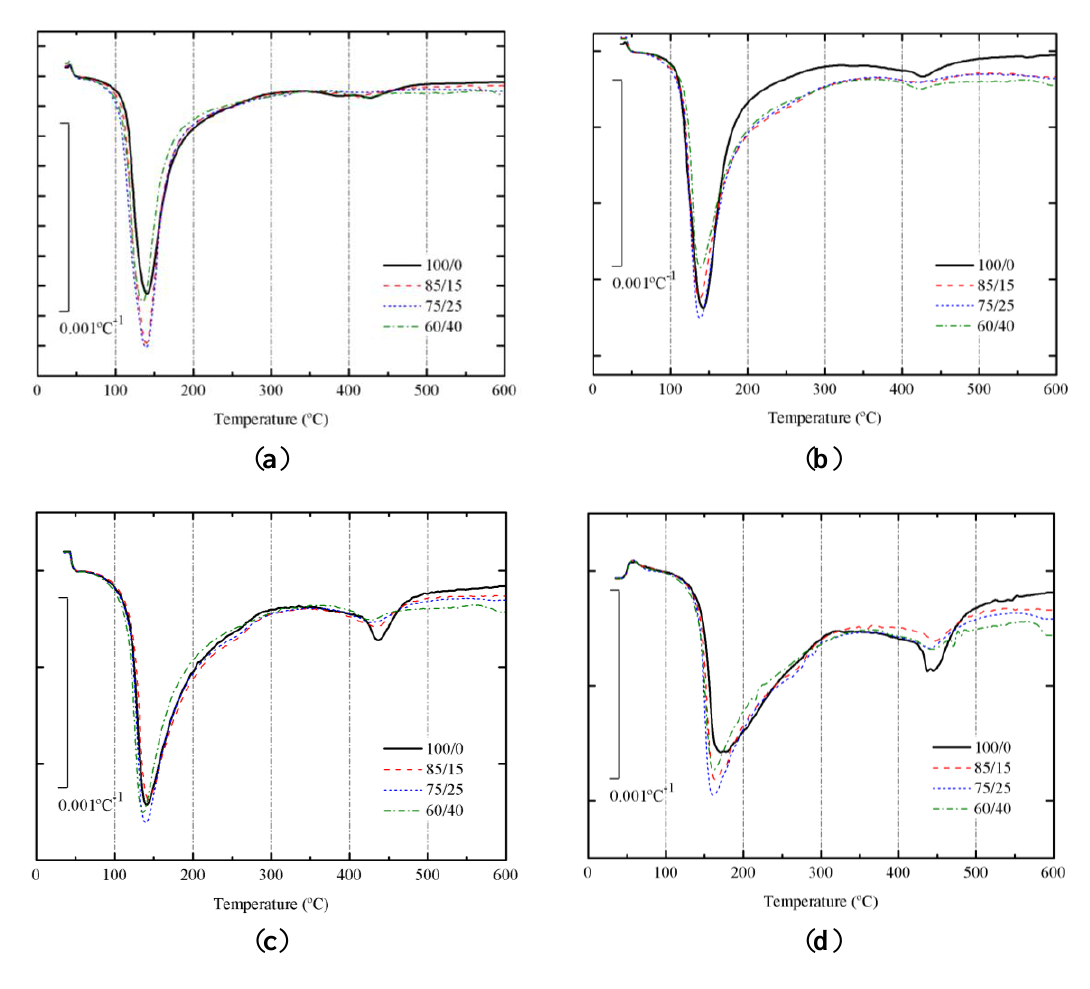
Figure 8. DTG curves for alkali activated BFS + SCBA pastes cured: ( a ) after 3 days at